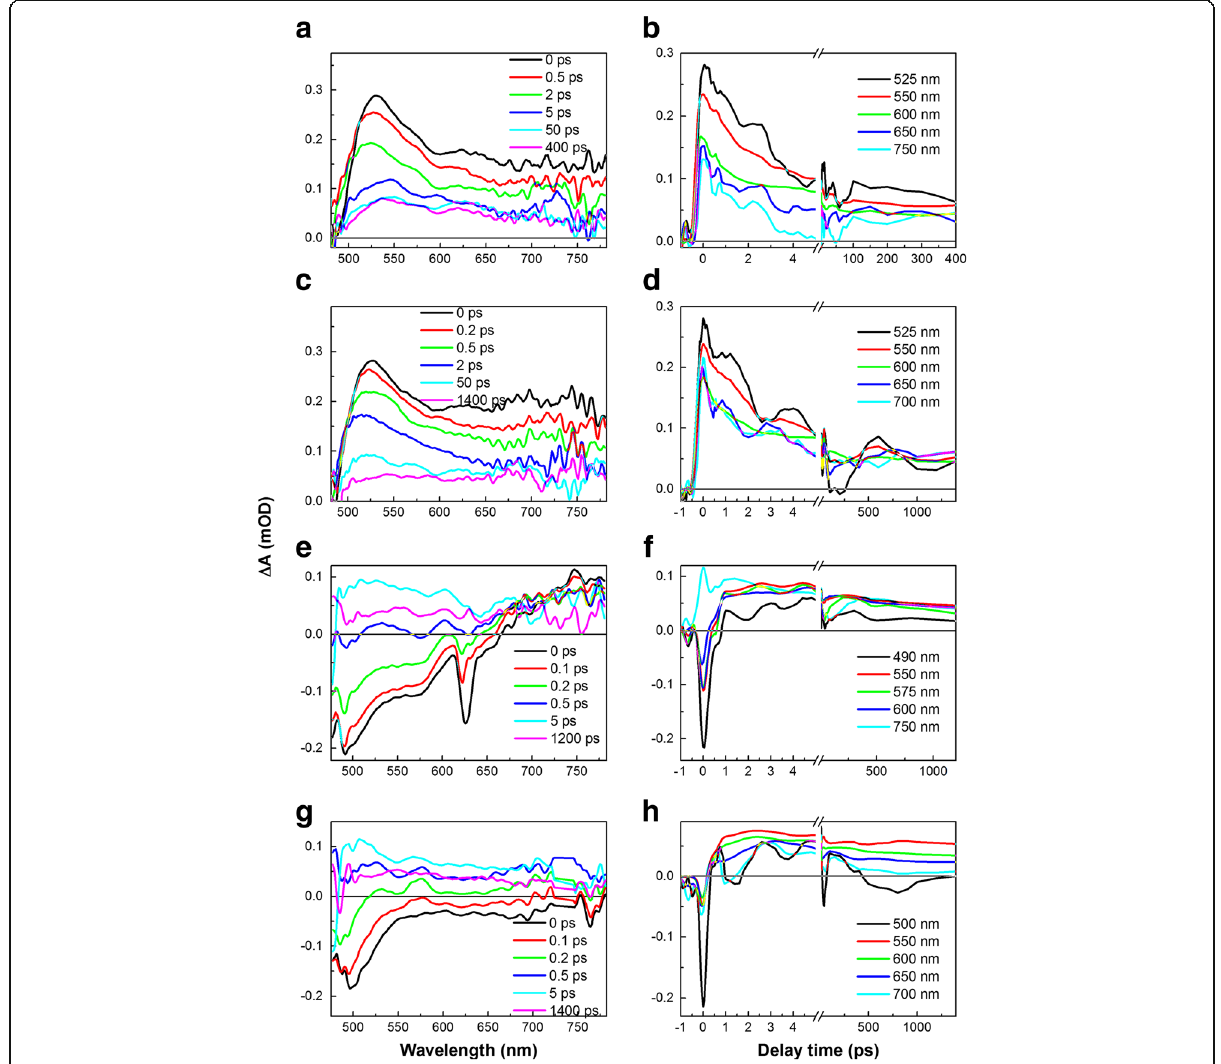
Fig. 4 TAS spectra of DLC:Ag nanocomposites excited at various wavelengths: 406 nm ( a , b ), 470 nm ( c , d ), 627 nm ( e , f ), and 736 nm ( g , h ). The excitation intensities were 9 μ J/cm 2 , 11 μ J/cm 2 , 50 μ J/cm 2 , and 51 μ J/cm 2 , respectively